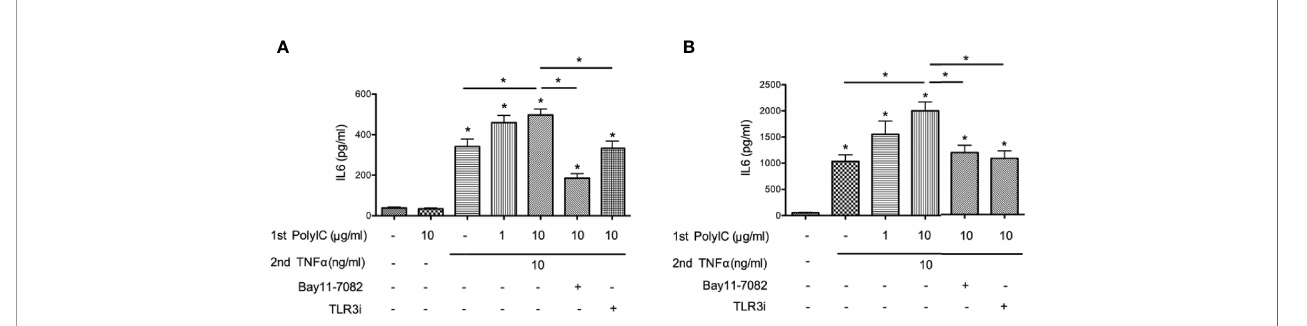
FIGURE 5 | IL6 release after PolyIC – WD – TNF in (A) MRC-5 cells and (B) HF-19 cells and the effect of TLR3 and NF- k B inhibitors on its release. Preexposure to Poly (I:C) signi fi cantly increased TNF a -induced IL6 release in both MRC-5 (P < 0.005) and HF-19 (P < 0.005) cells. Both inhibitors signi fi cantly decreased IL6 release in MRC-5 cells (P < 0.01 and P < 0.0001 for TLR3i and Bay-11-7082, respectively) and HF-19 cells (P < 0.01 and P < 0.05 for TLR3i and Bay-11-7082, respectively). N = 6. Values with * were de fi ned signi fi cant when compared to (-)-WD-(-) while *above bar were signi fi cant between